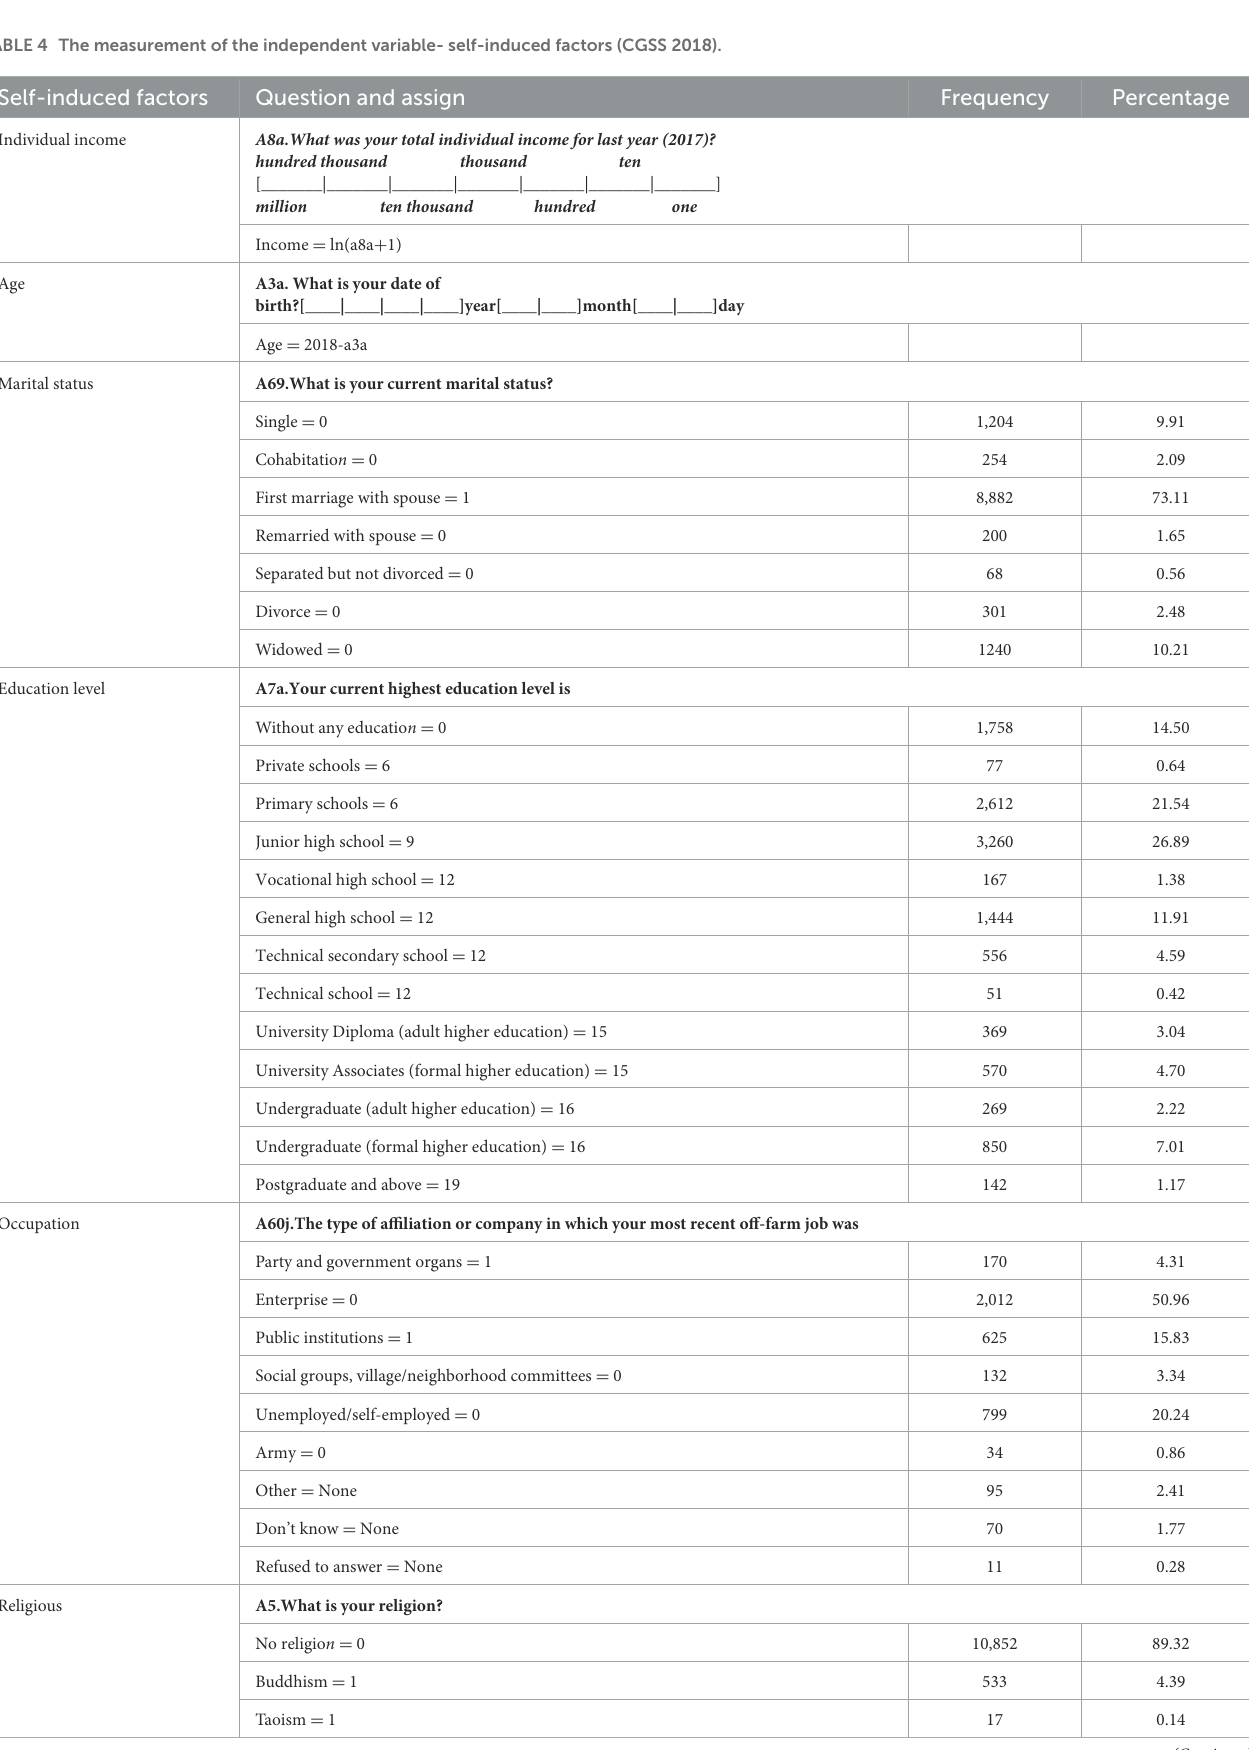
TABLE 4 The measurement of the independent variable- self-induced factors (CGSS 2018). Self-induced factors Question and assign Frequency